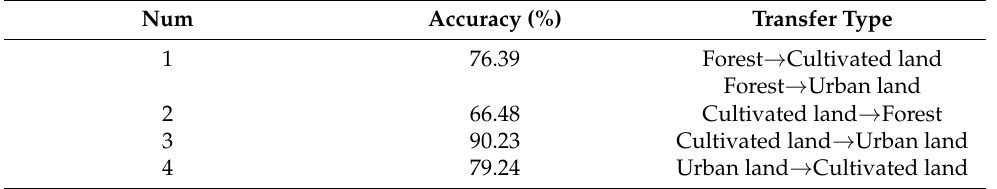
Table 5. The MLP accuracy of transition submodels in LCM model establishment.